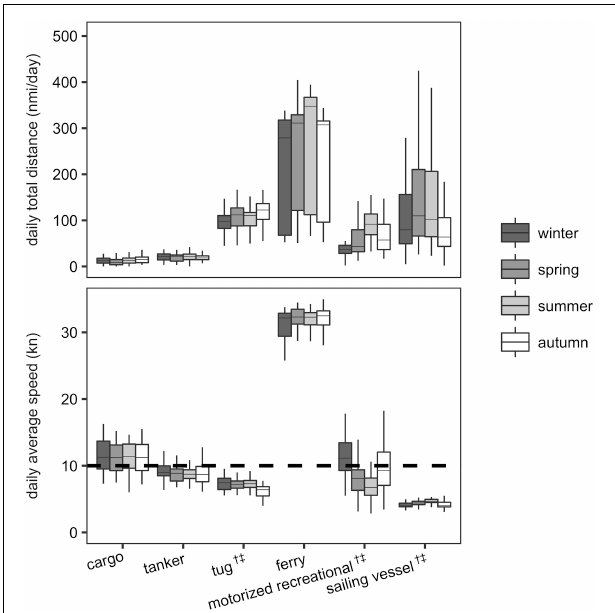
FIGURE 4 | Daily distance (nmi/day) (top) and average speed (kn) (bottom) by season for each vessel class. Box and whisker plots show sample minimum, maximum, median, and first and third interquartile values. Outliers are not shown. Statistically significant differences in median daily distance between seasons denoted by † ( p < 0.01). Statistically significant differences in median speed between seasons denoted by ‡ ( p < 0.01). Dashed line indicates 10-kn voluntary speed restriction used in National Marine Sanctuaries outside San Francisco Bay (United States Coast Guard [USCG], 2017). Sample sizes: n 1 = 32 days (winter), n 2 = 45 days (spring), n 3 = 51 days (summer), n 4 = 47 days